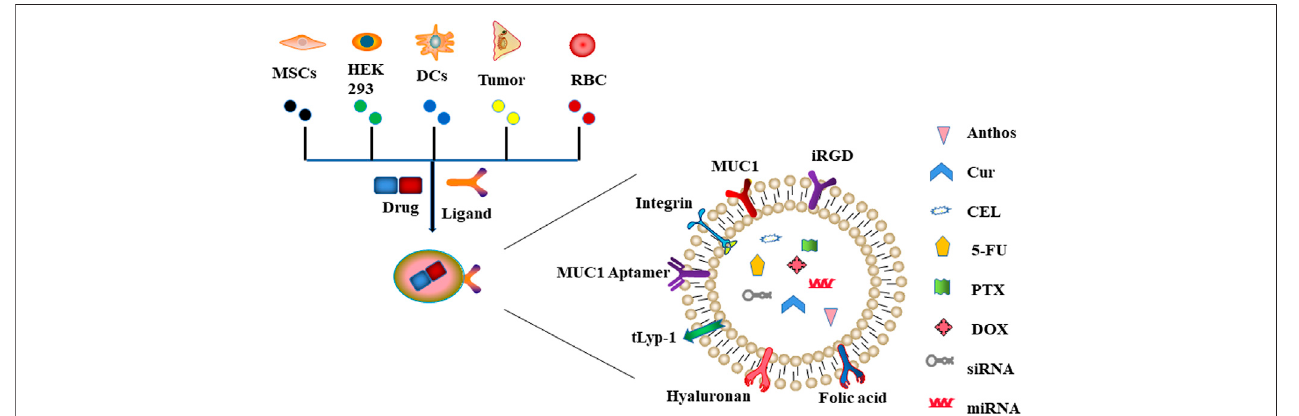
FIGURE 2 | Schematic representation of exosome-based drug delivery systems. Exosomes derived from different types of cells (including MSCs, HEK293, DCs, tumor, and RBC) can deliver drugs to cancer cells through innate or acquired ligands expressed on the surface of exosomes.